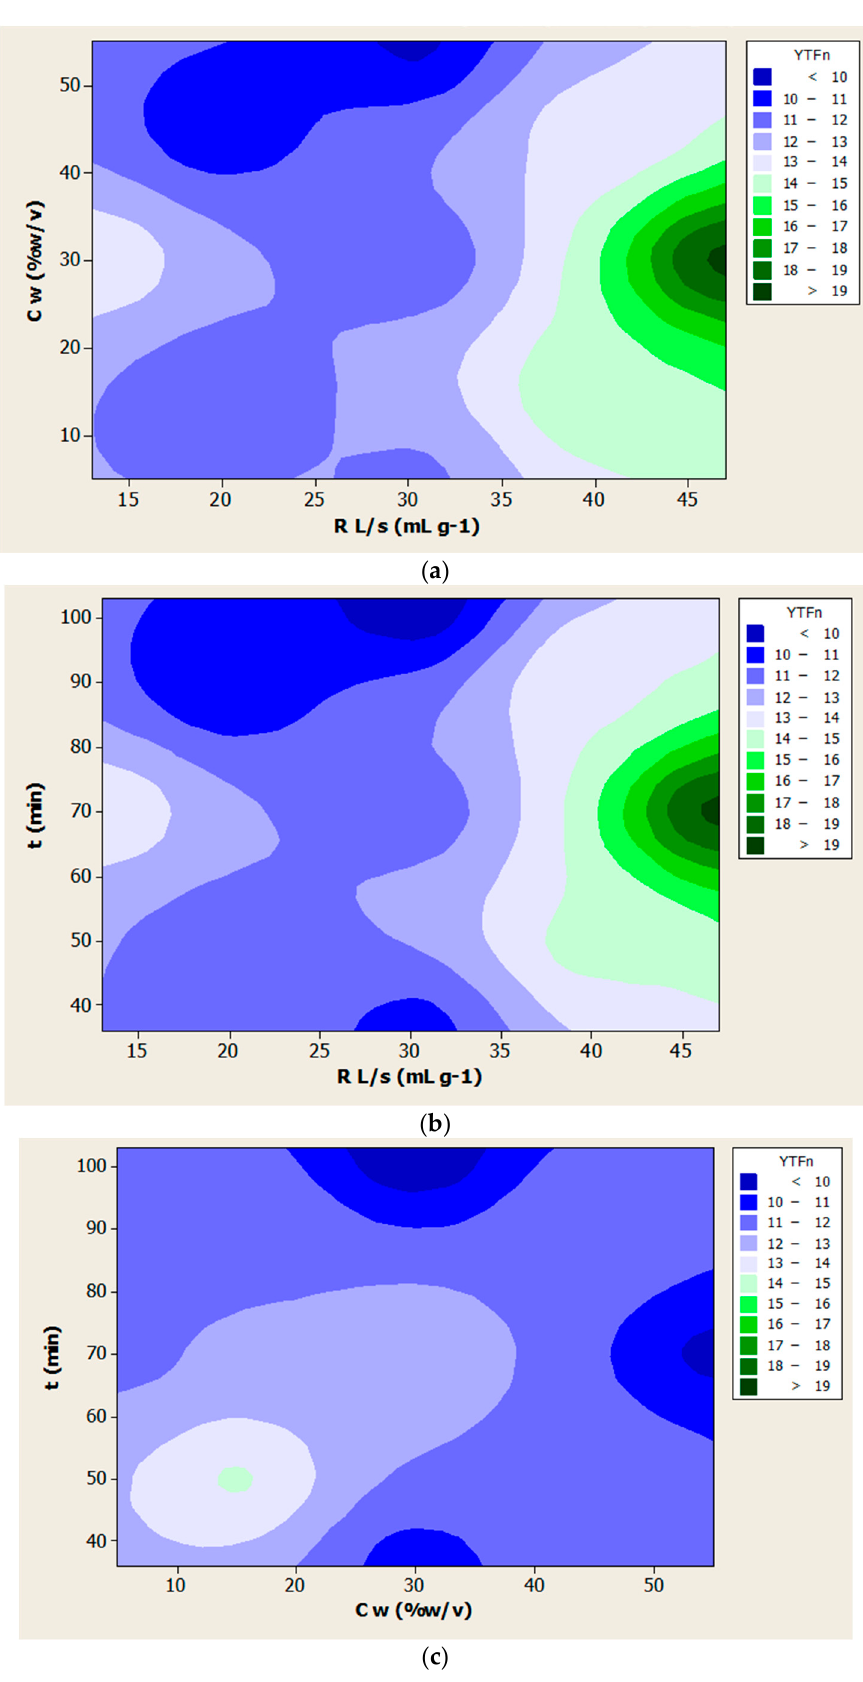
Figure 2. Contour diagrams ( a – c ) for the extraction yield of total flavonoids (YTF).